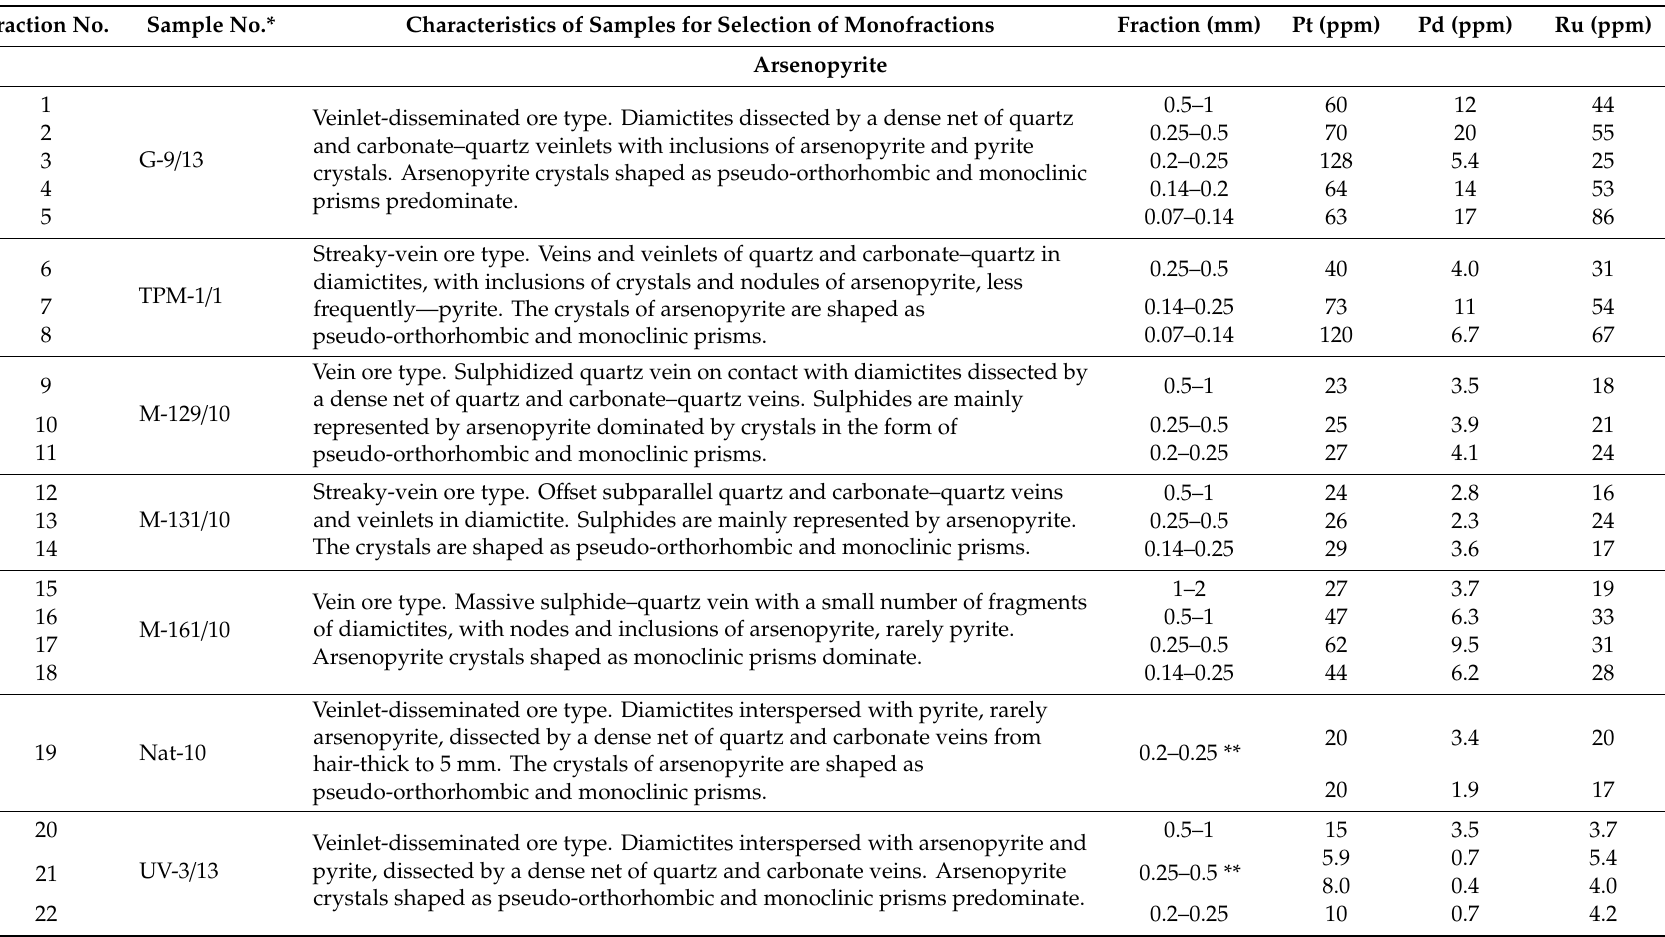
Table 1. Platinum, palladium and ruthenium content in di ff erent-sized monofractions of arsenopyrite and pyrite selected from vein, streaky-vein and veinlet-disseminated ores of the Natalkinskoe